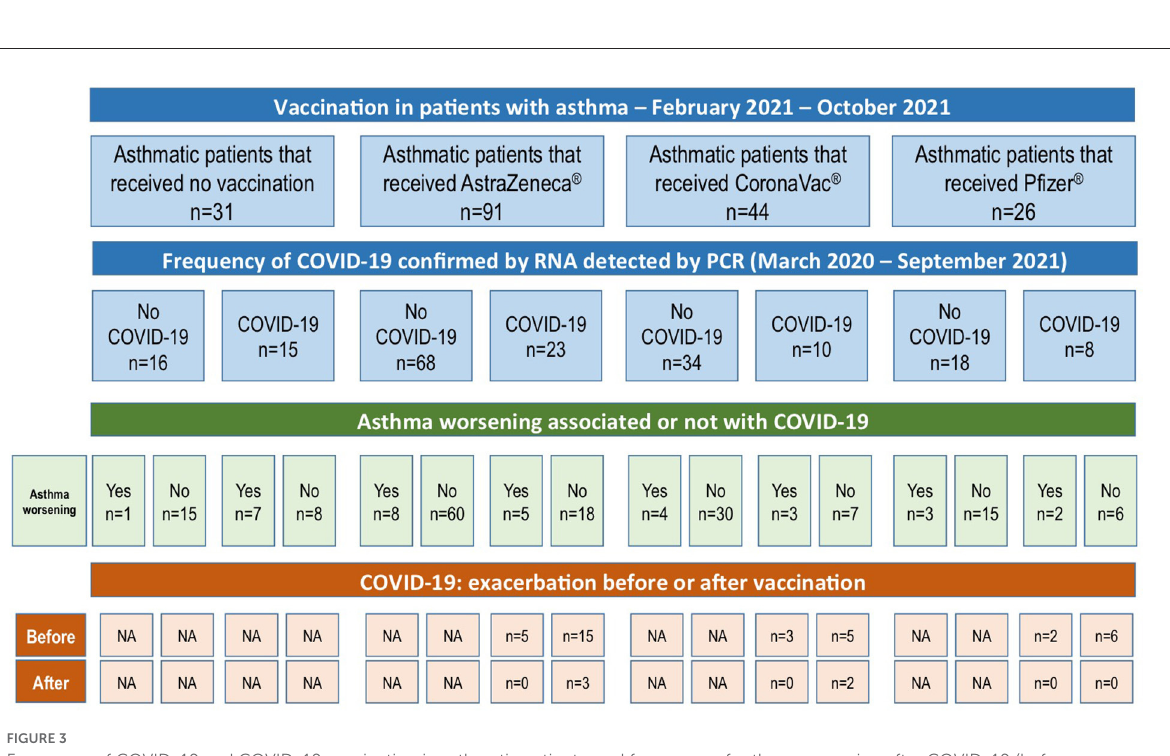
FIGURE3 Frequency of COVID-19 and COVID-19 vaccination in asthmatic patients, and frequency of asthma worsening after COVID-19 (before or after